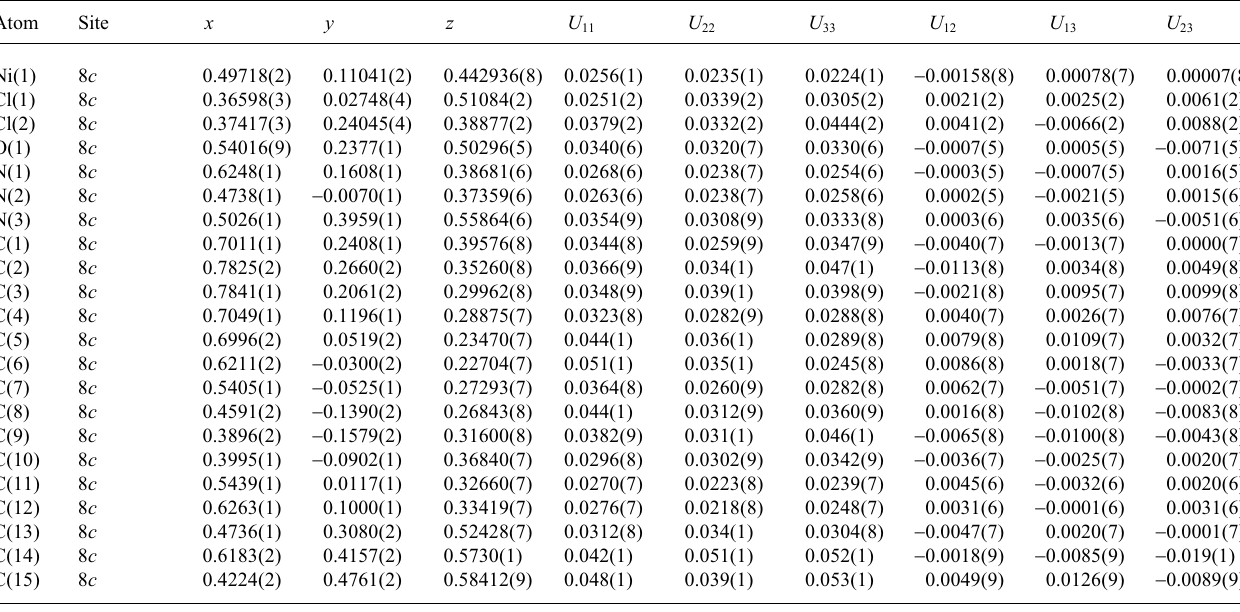
Table 3. Atomic coordinates and displacement parameters (in Å 2 )